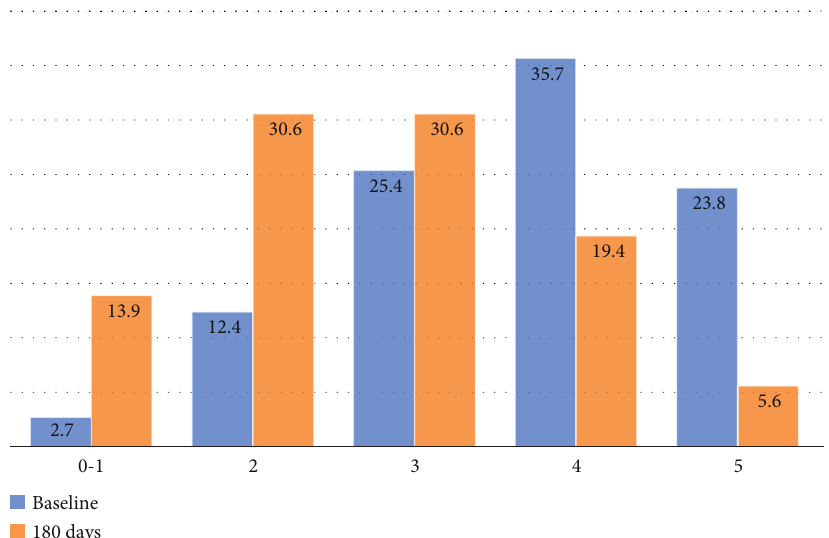
Figure 1: Number of components of the metabolic syndrome at baseline and after 180 days of treatment with Gdue. Components of the metabolic syndrome according to the IDF criteria [2]: waist circumference ( M ≥ 94 cm; F ≥ 80 cm); triglycerides > 150 mg/dL; HDL cholesterol ( M < 40 mg/dL; F < 50 mg/dL); blood pressure (systolic blood pressure ≥ 130 mmHg or diastolic blood pressure ≥ 85 mmHg or antihypertensive treatment); impaired fasting glucose or type 2